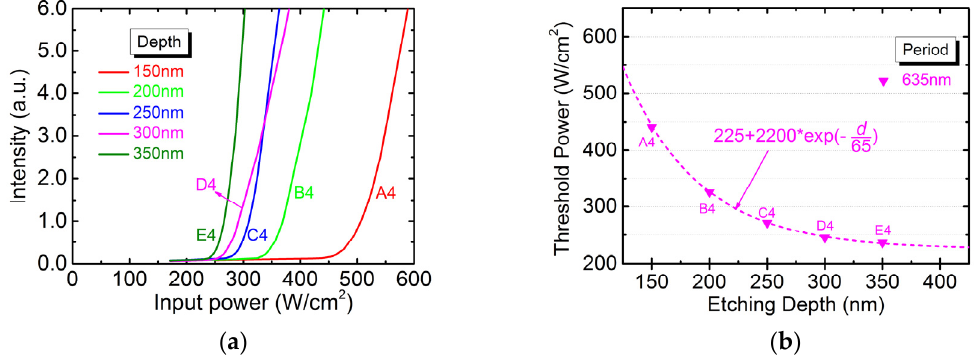
Figure 4. ( a ) The light-in versus light-out ( L ‒ L ) curves and ( b ) the dependence of threshold power density on the etching depth for 635-nm-period devices.